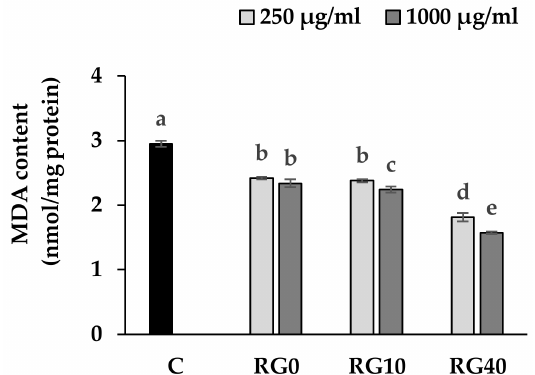
Figure 5. Level of malondialdehyde (MDA) in RAW264.7 cell line treated with selenium biofortified ricegrass juice extract (RG0, RG10, RG40) at level 250 and 1000 µ g/mL compared to control. RG0; ricegrass juice extract (control), RG10; ricegrass juice fortified with 10 mg Se/m 3 extract, RG40;